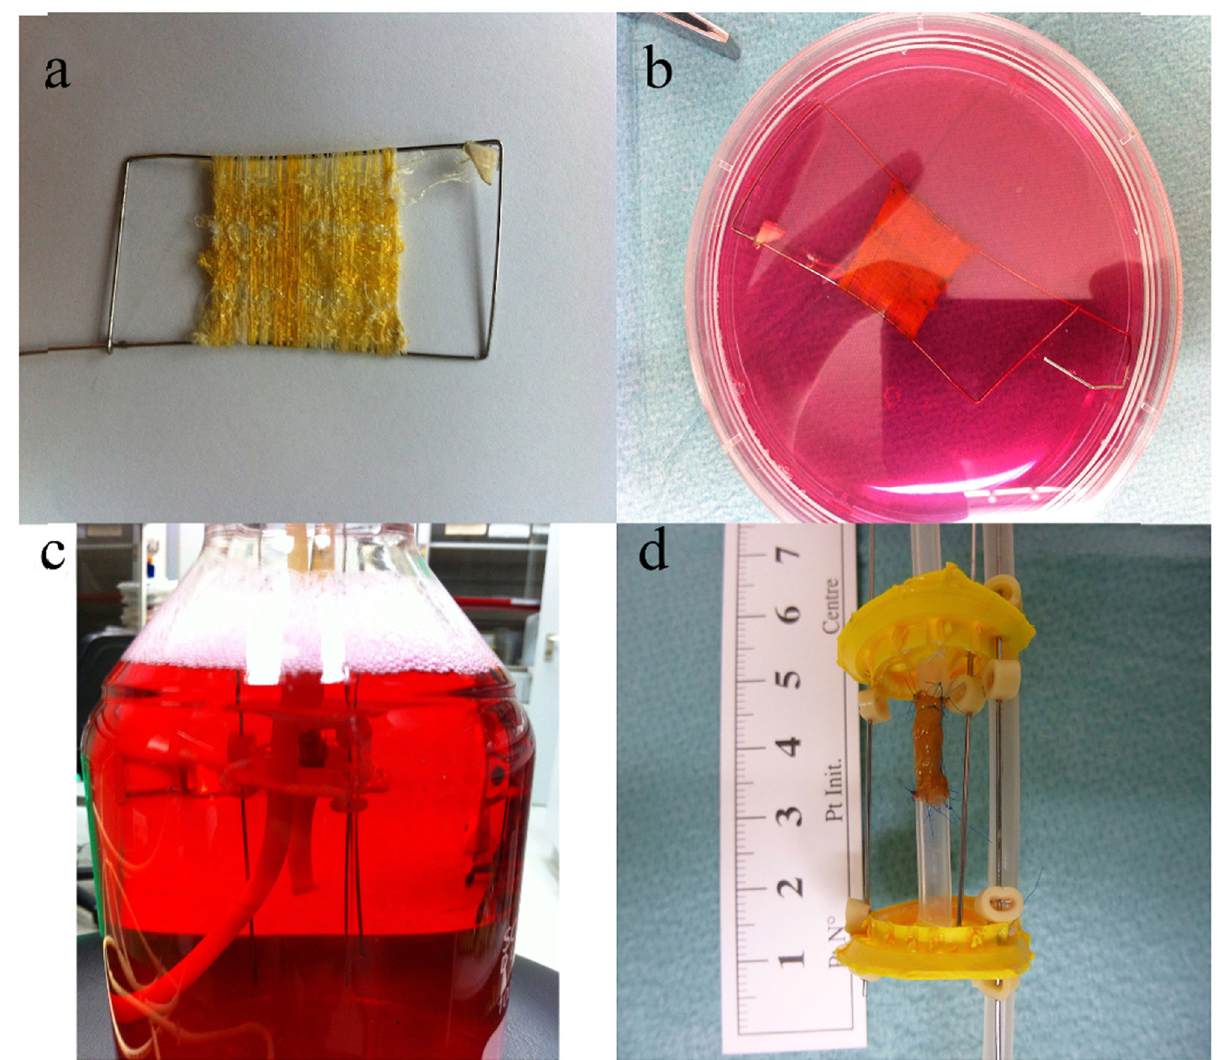
Figure 4: Arti fi cial blood vessel preparation process ( 78 ) . ( a ) Spider silk sca ff old. ( b ) C2C12 and ST1.6R were cultured on both sides of the spider silk sca ff olds. ( c ) Constructed blood vessels were induced by pulsatile fl ow in the bioreactor. ( d ) Tissue - engineered vascular graft after 3 weeks